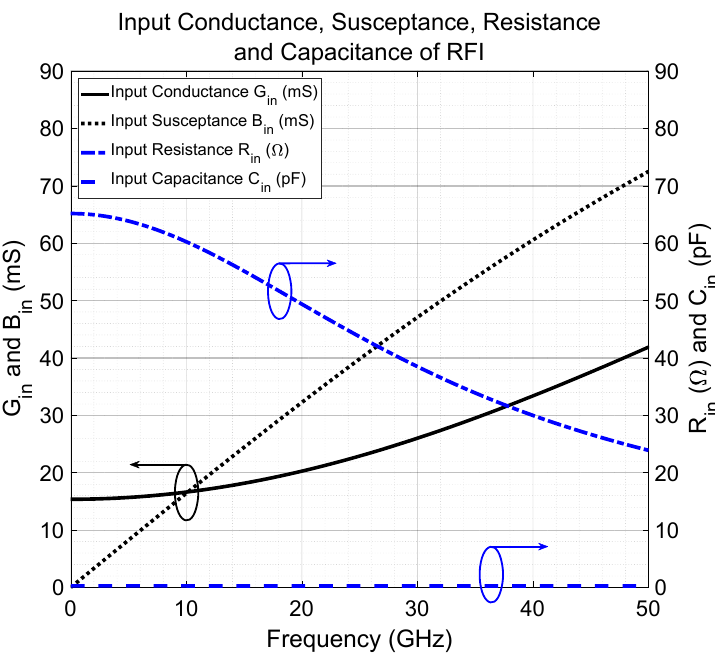
Figure 4. Input conductance ( G in ) and susceptance ( B in ) of the RFI.